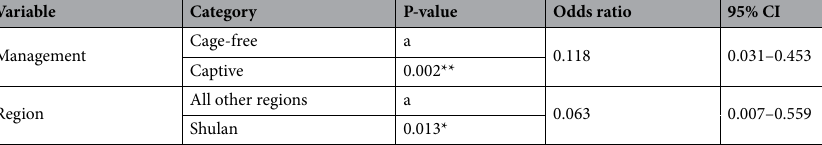
Table 3. Results of the multivariable logistic regression analysis for the prevalence of Toxoplasma gondii . a, baseline; 95% CI, confidence interval.